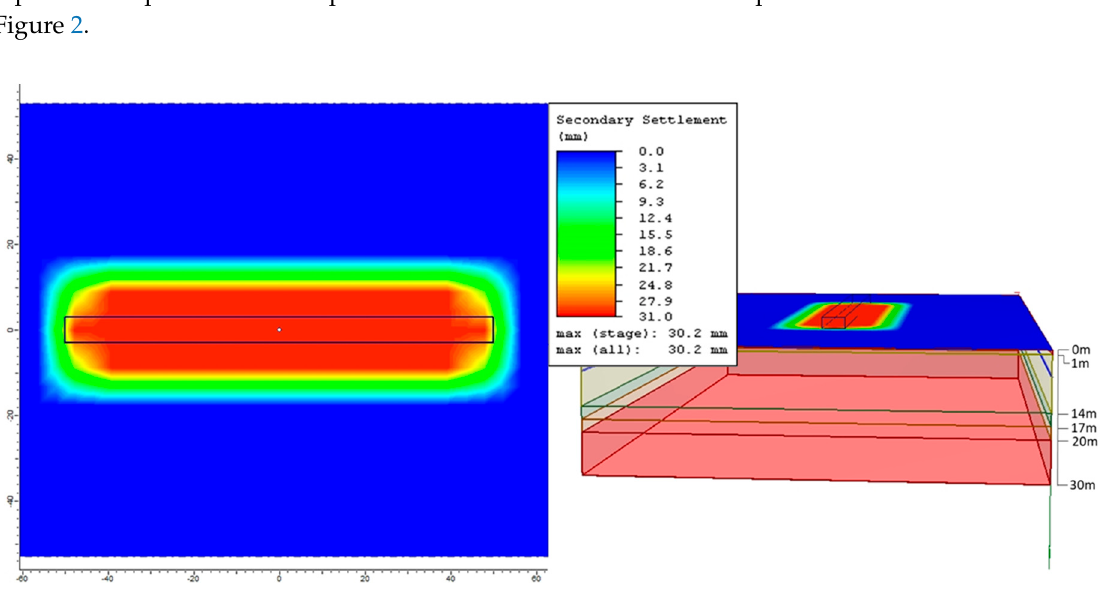
Figure 9. Settlement analysis of the rockfill profile at the internal zone for freshly placed rockfill with a 24kPa strip foundation was simulated. The plan view is presented on the left side of the figure. The dot in the center of the plan view indicates the query point on which the settlement was calculated. The 3D model is presented on the right side of the figure. The soil layers and their depths are indicated in the 3D model.